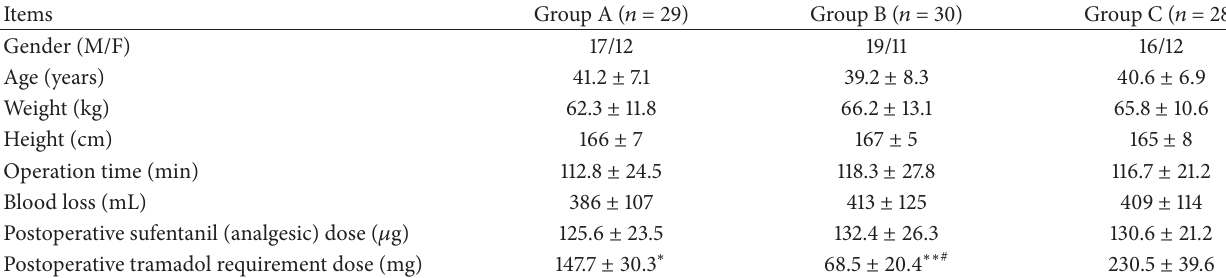
Table 1: General data of the three groups (mean ± SD).